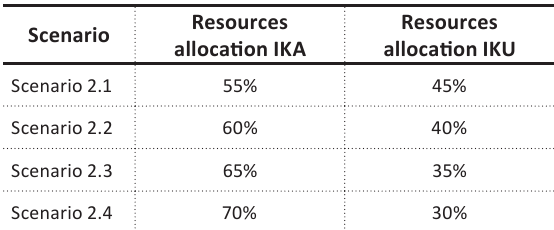
Table 3. Combination of scenario 2